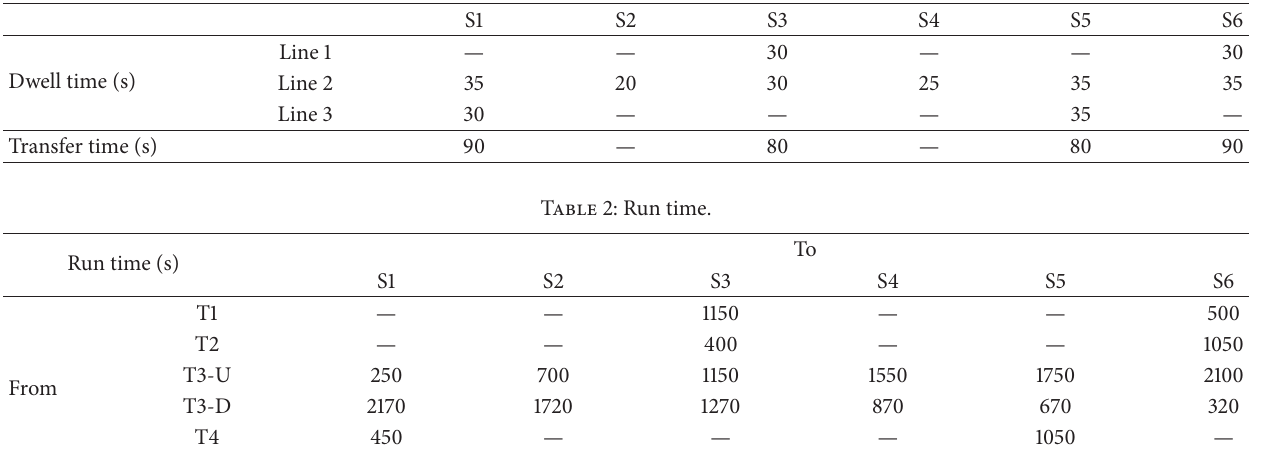
Table 1: Dwell time of trains and transfer time of passengers.